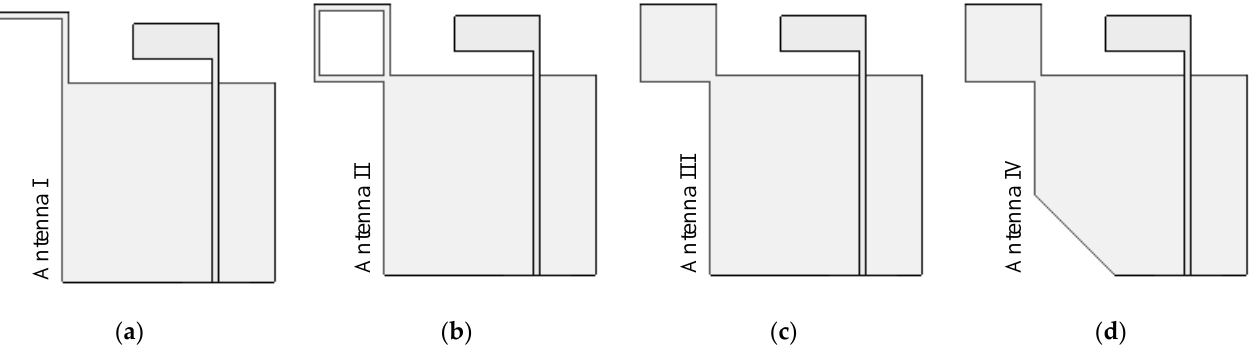
Figure 7. The evolutionary stages of the branch inverted L-shaped partial ground plane patch antenna: ( a ) Antenna I, ( b ) Antenna II, ( c ) Antenna III, ( d ) Antenna IV.